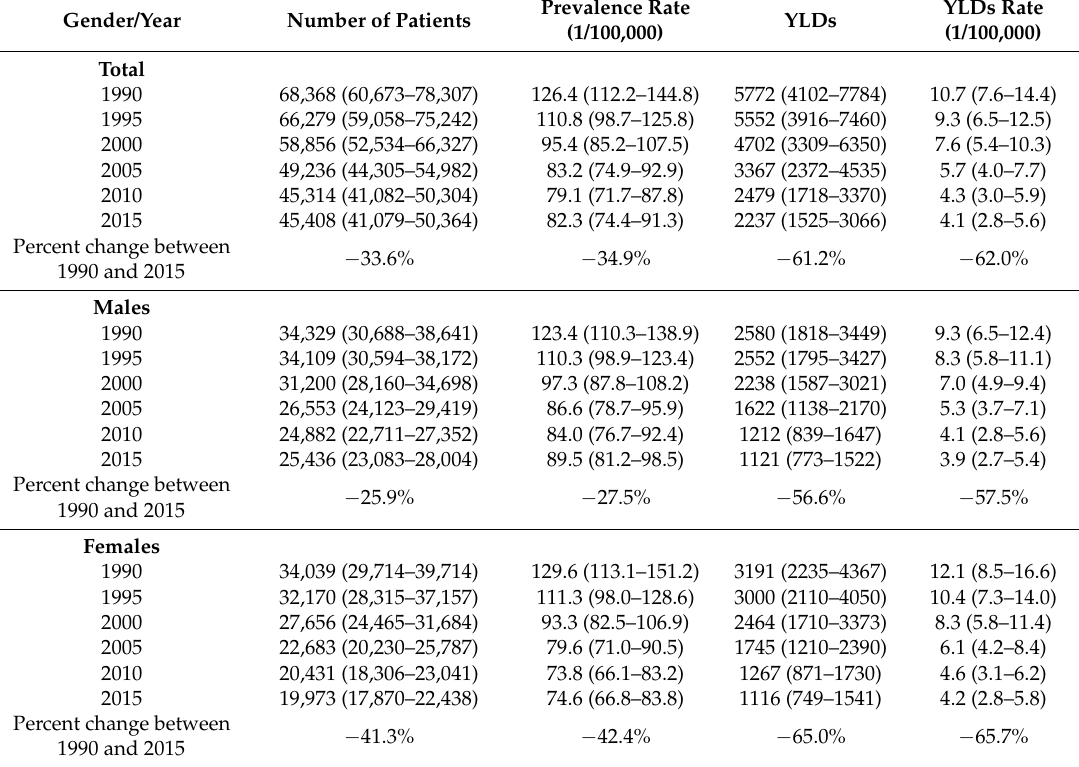
Table 2. Non-Fatal outcome of self-harm in Hubei,